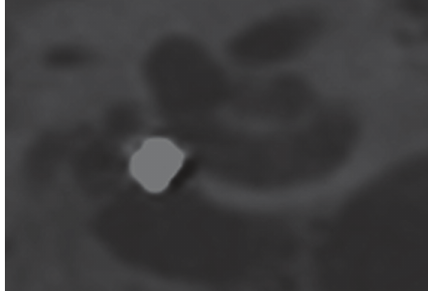
Figure 2: Type IV coupling—FMT directly at the RW in a rectan- gular position.